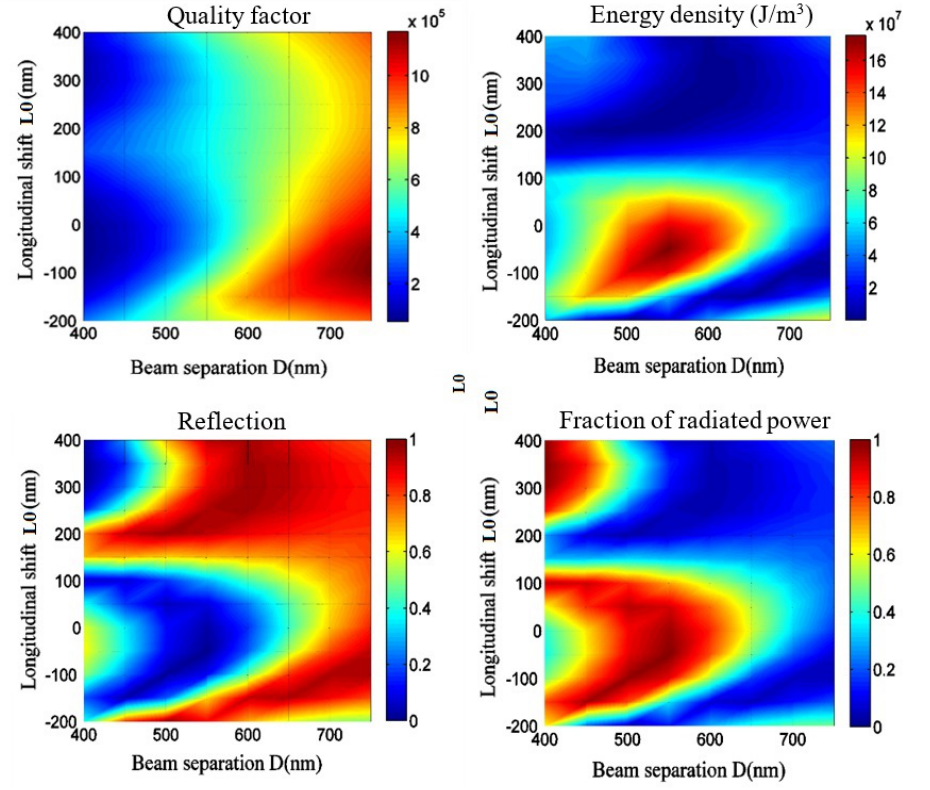
Figure 8. Optimization of D and L 0 for the optical mode at λ = 1615 nm (uniform cavity).